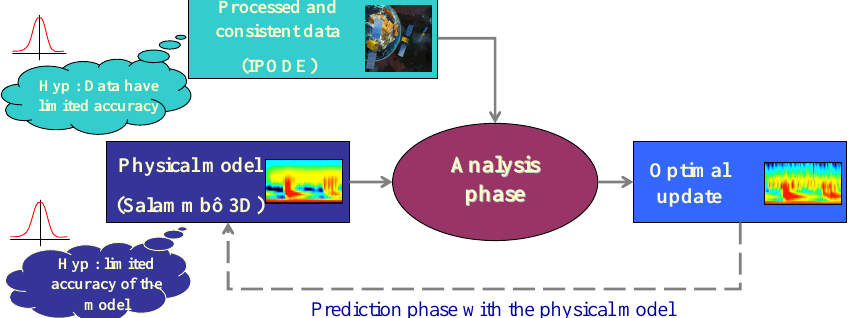
Fig. 4. A schematic view of a sequential data assimilation approach where IPODE is the Ionising Particle ONERA DatabasE and Salammbˆo 3-D the radiation belt physical